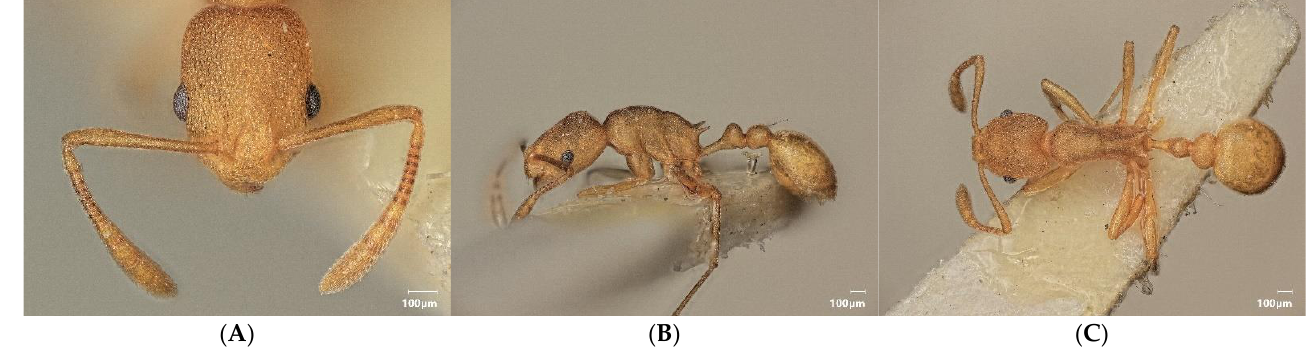
Figure 27. Cardiocondyla papuana : head in dorsal view, ( A ), lateral view ( B ), dorsal view ( C ).